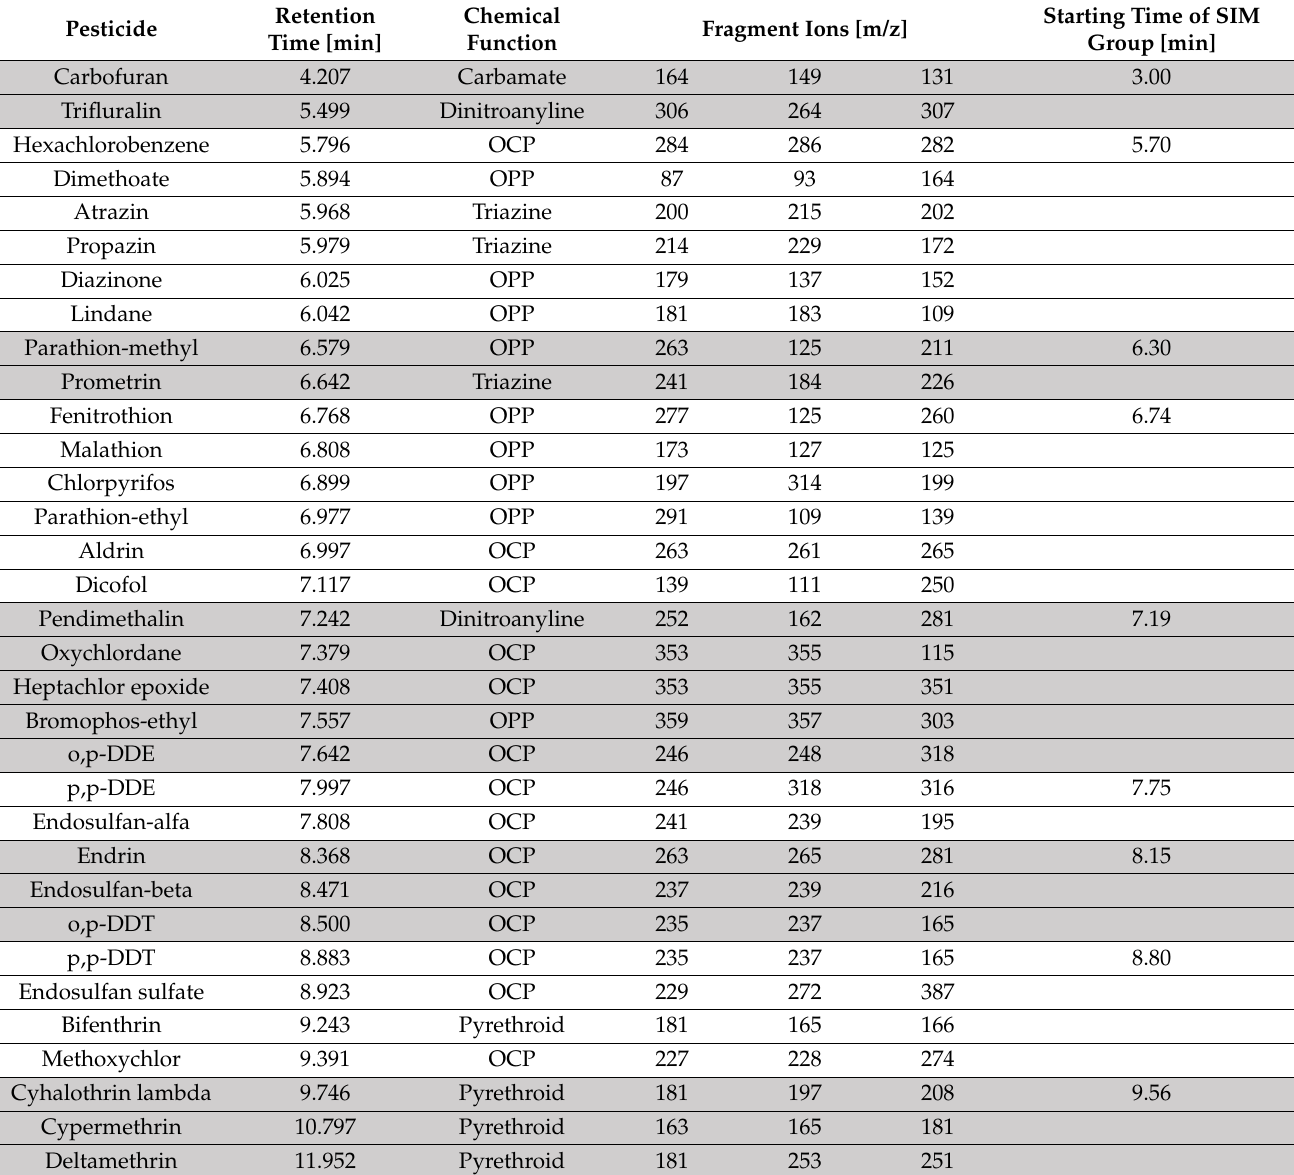
Starting Time of SIM Group [min]